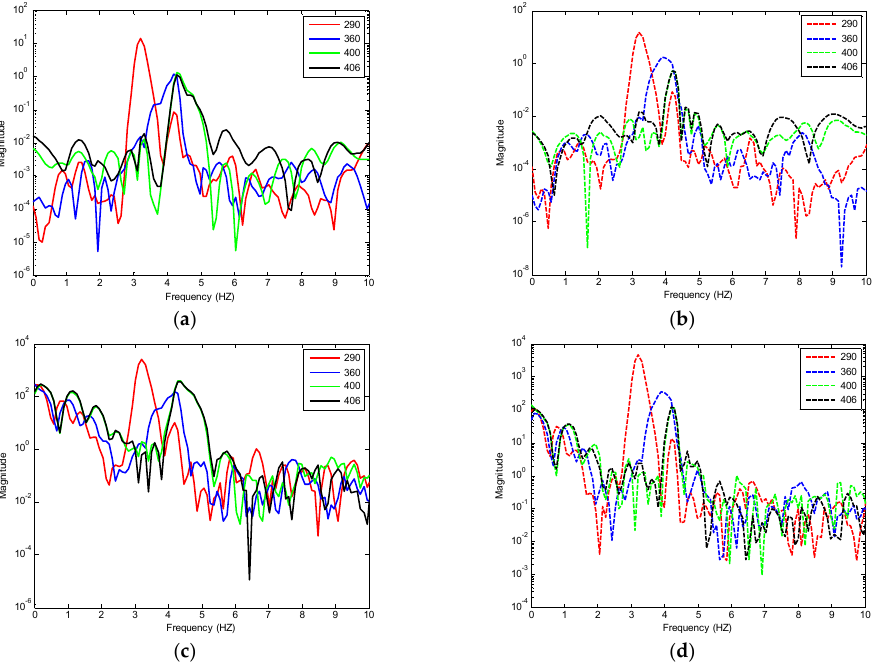
Figure 13. Acceleration and strain frequency contents. ( a ) passage-acceleration; ( b ) opposite-acceleration; ( c ) passage-strain; ( d ) opposite-strain.